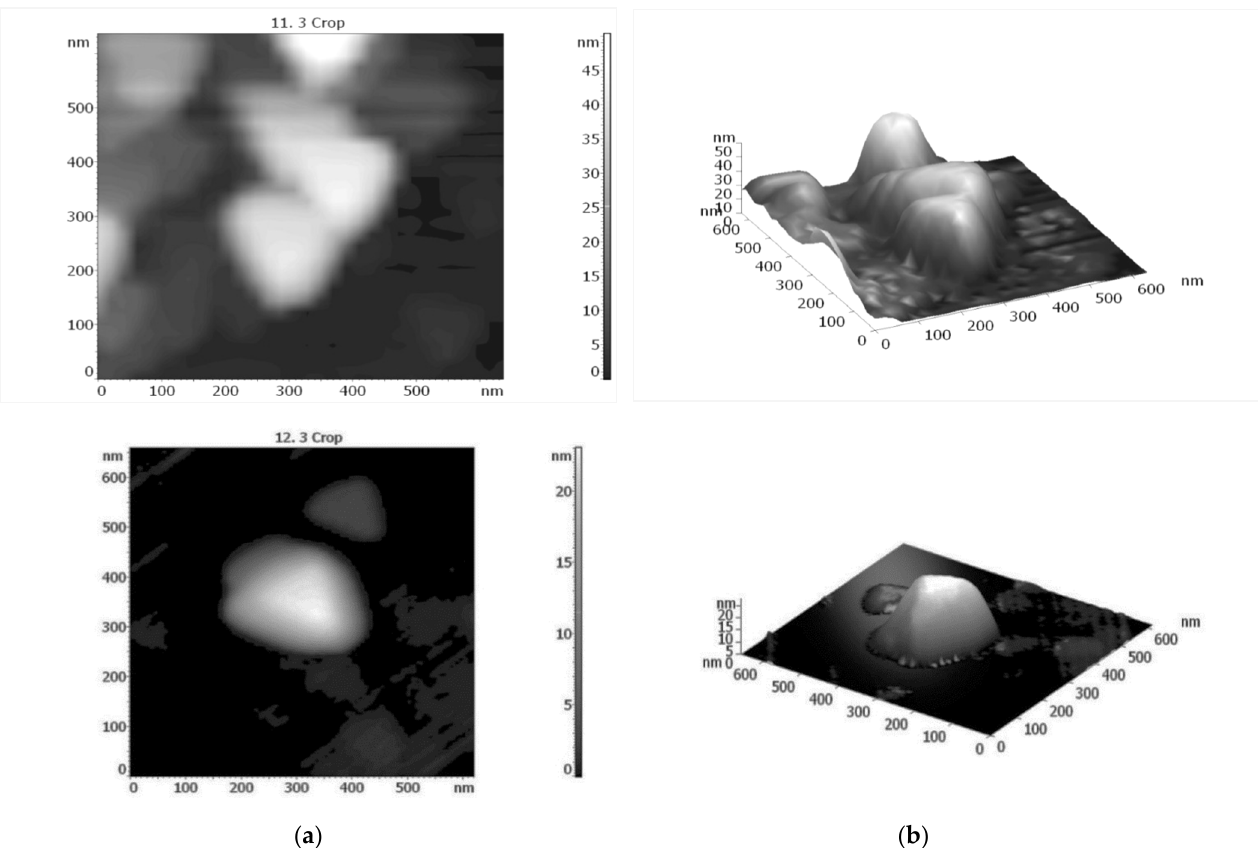
Figure 5. AFM two- ( a ) and three-dimensional ( b ) image of stable nanostructures based on model {Hem • Tyr • His} com- plexes.